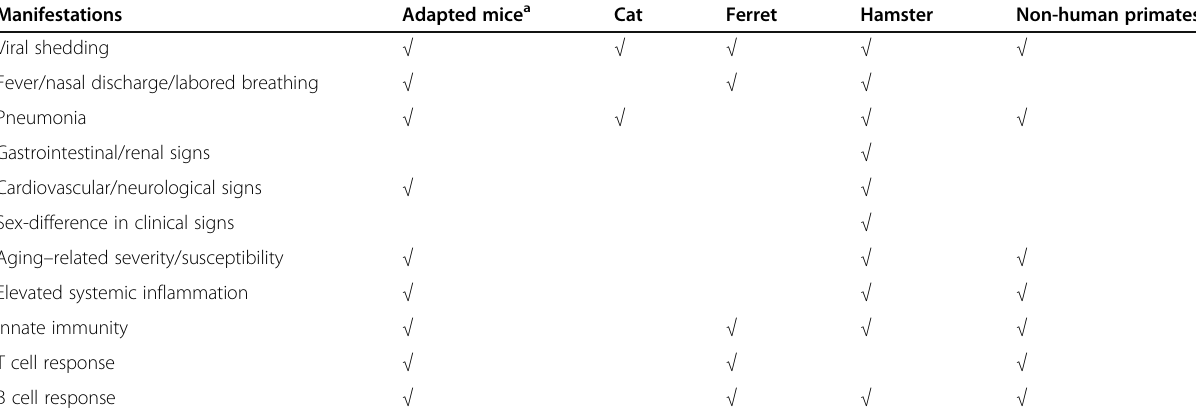
Table 4 Major SARS-CoV-2 animal models and reported manifestations